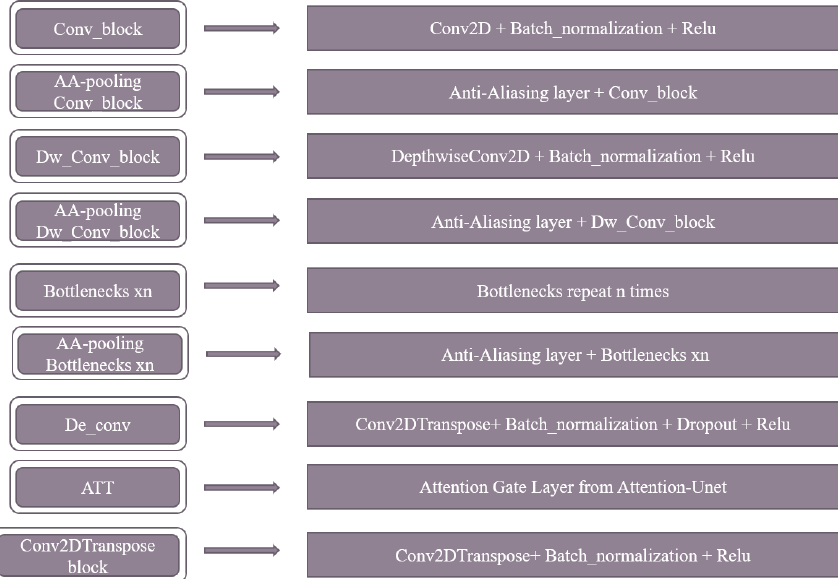
Figure 5. The attention block.